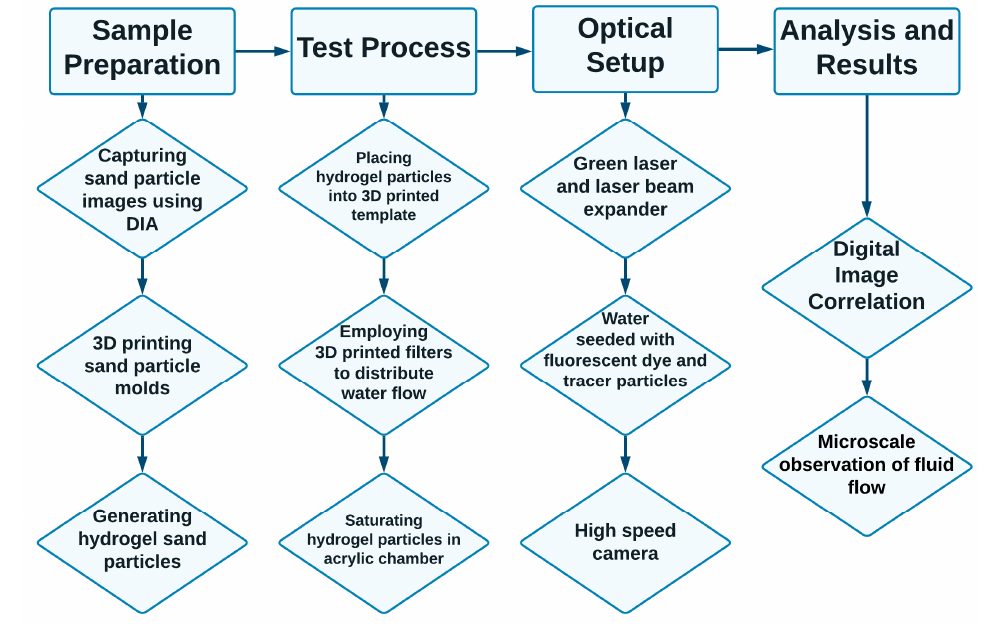
Figure 8. Overall procedures for visualization of interstitial pore fluid flow.